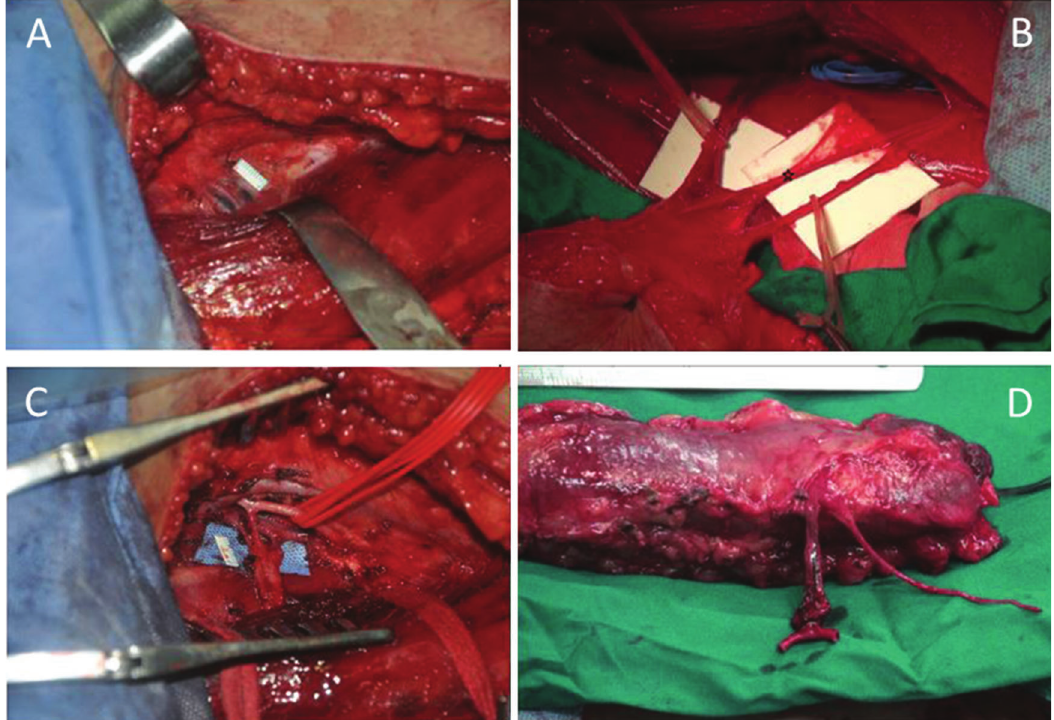
Figure 2 - Intraoperative images - A) Exposure of the dominant vascular pedicle. To avoid injury during the operation, the pedicle was not dissected at first. B) The neurovascular pedicle of the gracilis. Note that the sensory nerve branch ( $ ) must be resected to ensure enough motor nerve fiber regeneration (a, b). C) Exposure of the profunda femoris. A segment of the profunda femoris was prepared. It is unnecessary to perform a long dissection. D) The T-shaped arterial pedicle of the gracilis musculocutaneous flap (flap placed with the skin paddle